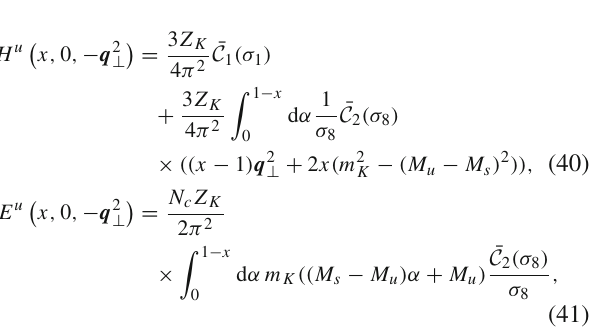
Fig. 7 Form factors normalized to their own charge: F u – dashed red K curve, B u – dot-dashed black curve, A u – dotted orange curve, A u 1 , 0 2 , 0 2 , 2 – solid blue curve, B u – dashed purple 2 , 0